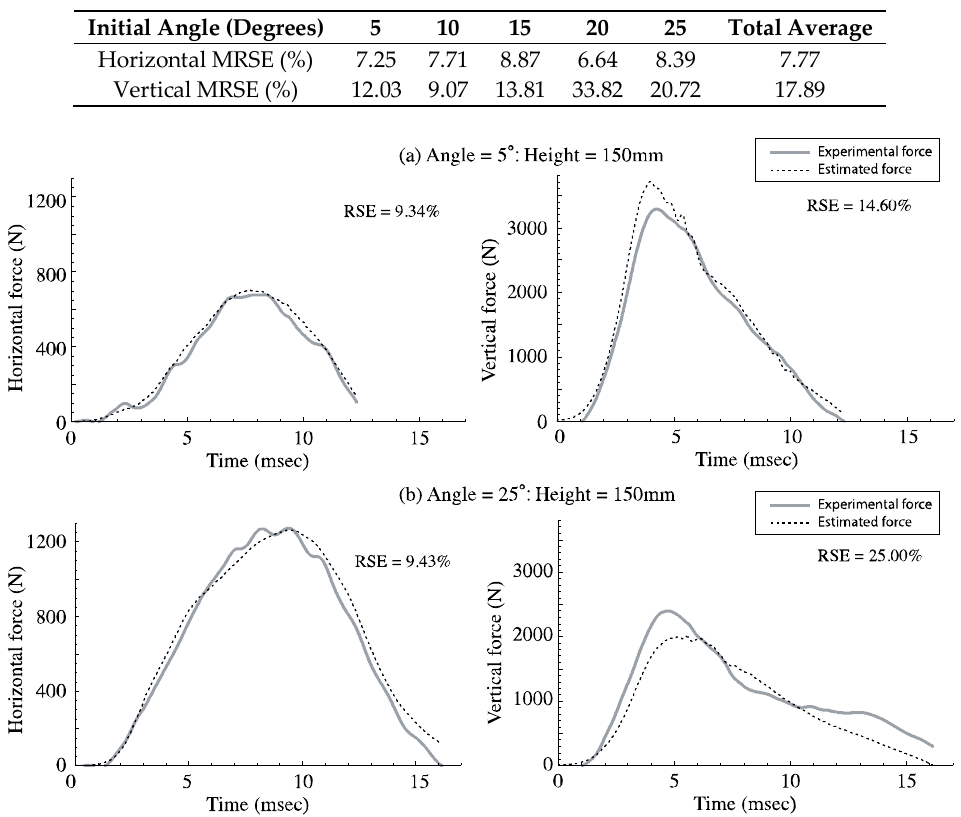
Table 1. Horizontal and vertical MRSE (mean relative standard error) between experimental force and estimated force with each initial angle and total average of MRSE.